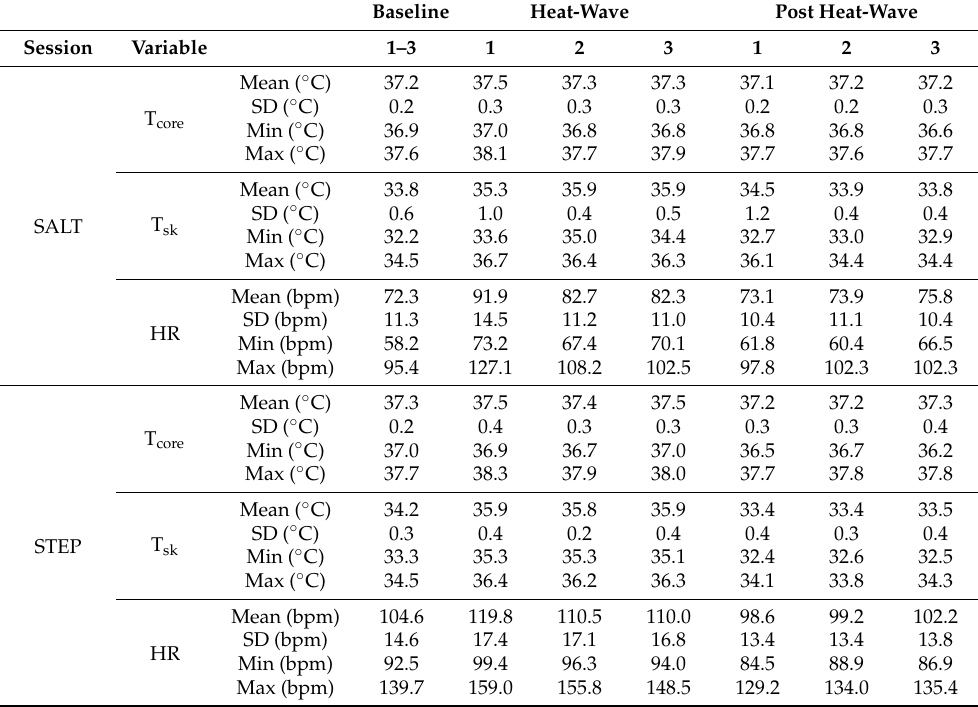
Table A1. Average (i.e., mean average, min average, and max average) physiological values during the 1-h simulated assembly line task (SALT) and the 40-min stepping session